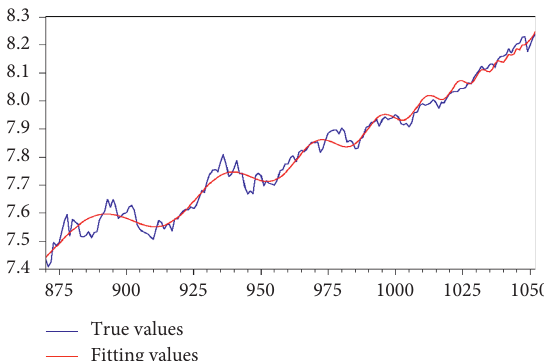
Figure 12: Fitting results from 2008/11 to 2009/7.